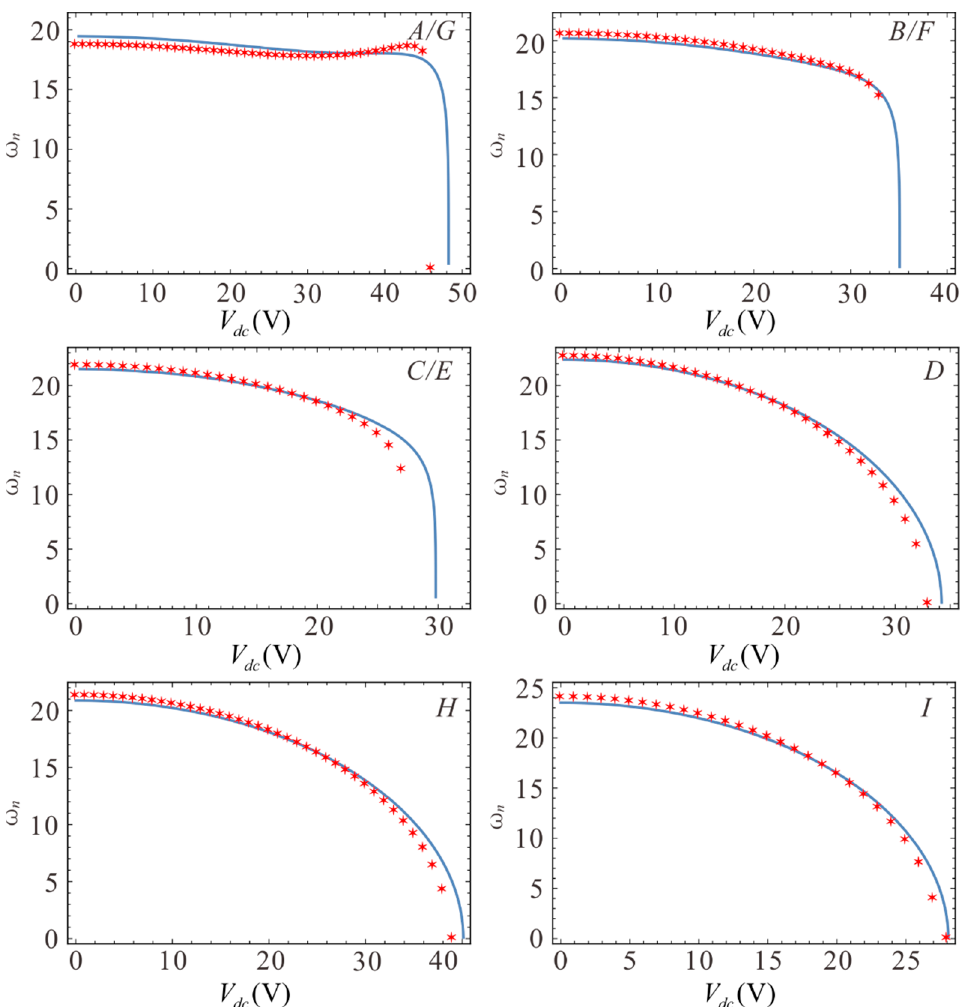
Figure 17. Electrostatic force softening effect in different cases. Lines show the analytical solutions and pentagons show the finite element solutions.